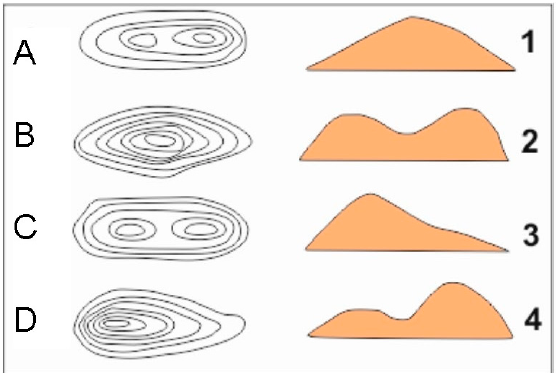
Figure 5. Example of an exercise where the students had to match the letter and number or the topographic map and the topographic section. The correct answers are A4, B1, C2, and D3.